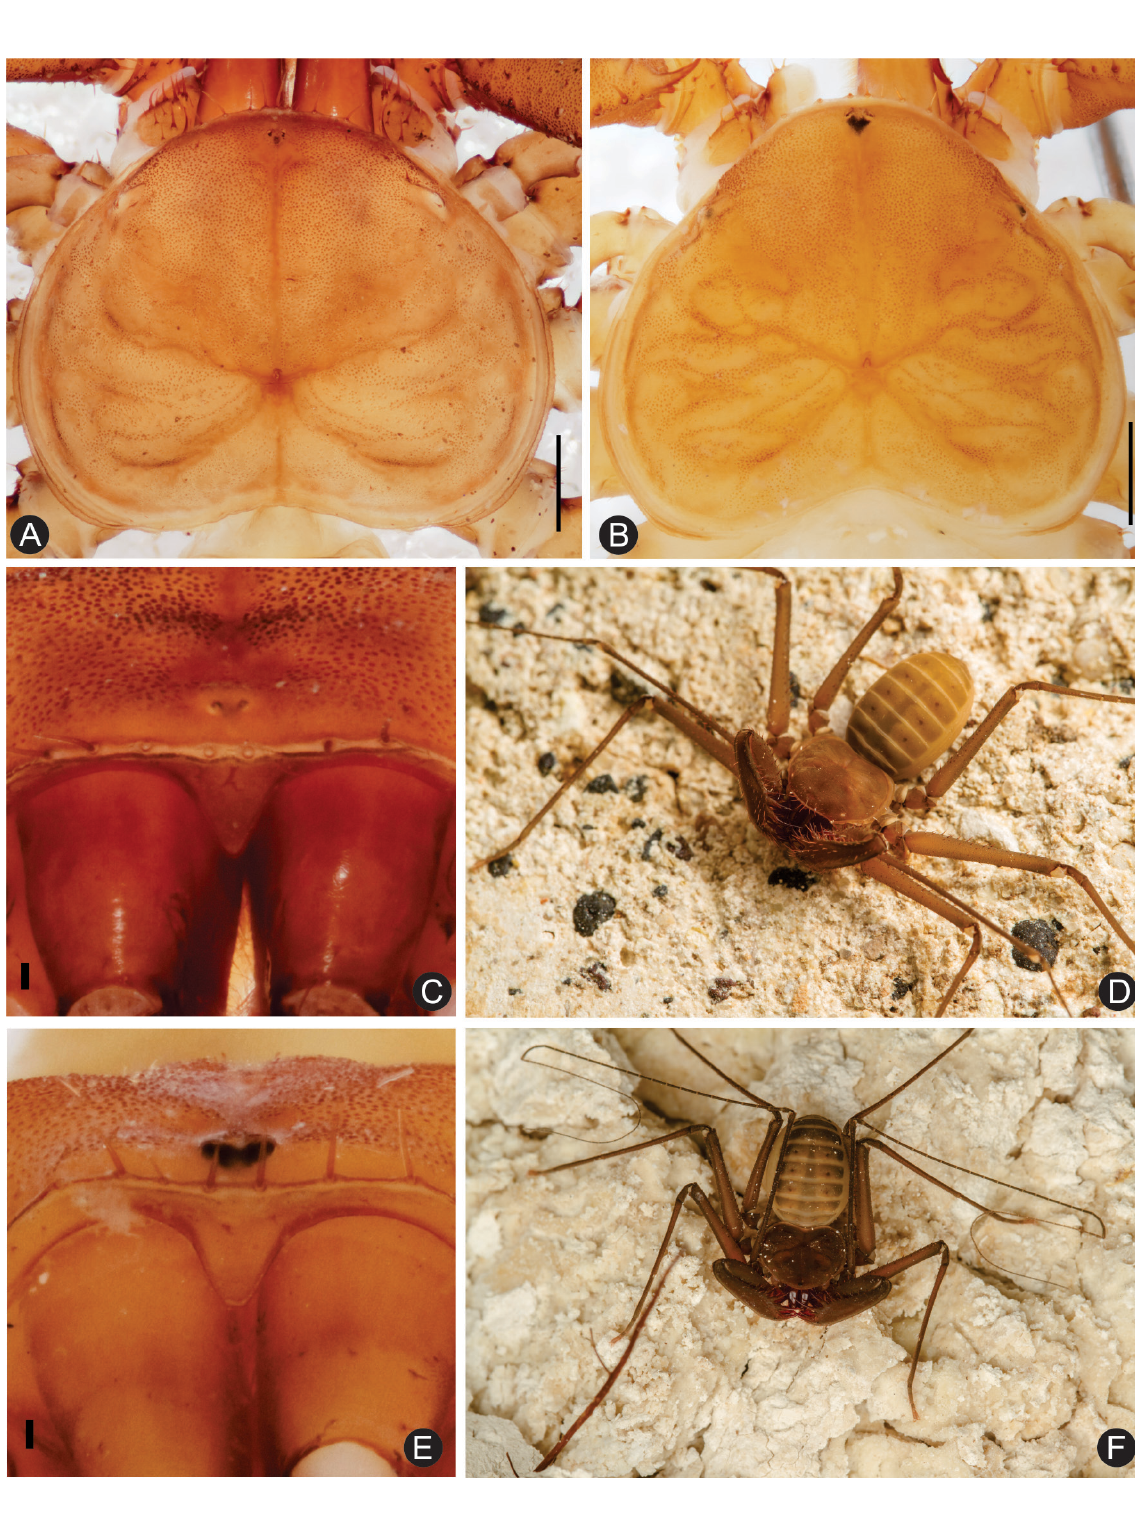
Fig. 4. Carapace, frontal process and habitus. A, C–D . Charinus israelensis sp. nov. B, E–F . C. ioanniticus (Kritscher, 1959). Scale bars: A–B = 1.0 mm; C–E = 0.1